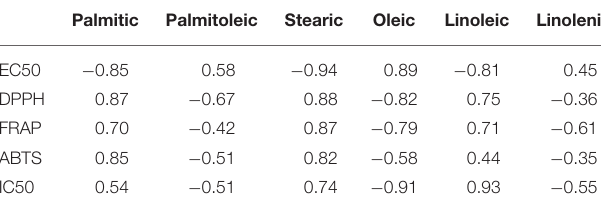
TABLE 3 | Analysis of correlation performed taking into consideration the values of the antioxidant (EC50, DPPH, FRAP, ABTS) and anti-inflammatory activity (IC50) of the oils with the fatty acid composition, using the free software environment for statistical computing and graphics R